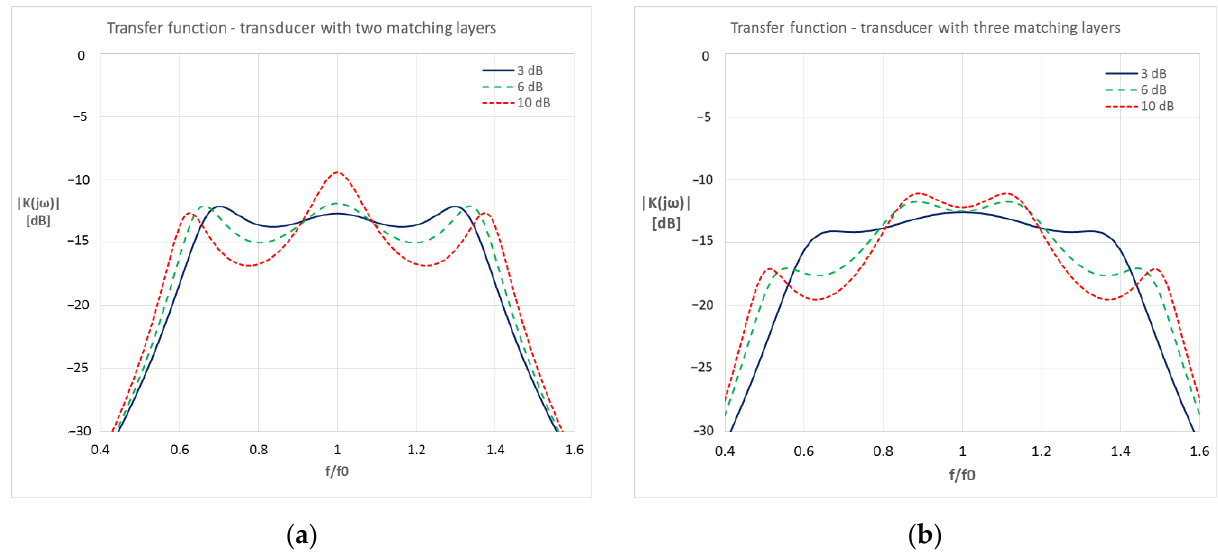
Figure 6. Analysis of the transfer function for the transducer operated in water (influence of maximum allowed unevenness): ( a ) 2 matching layers, ( b ) 3 matching layers. Table 4. Acoustic impedances of the matching layers obtained with the genetic algorithm (skull bone, Z T = 7800 kRayl).